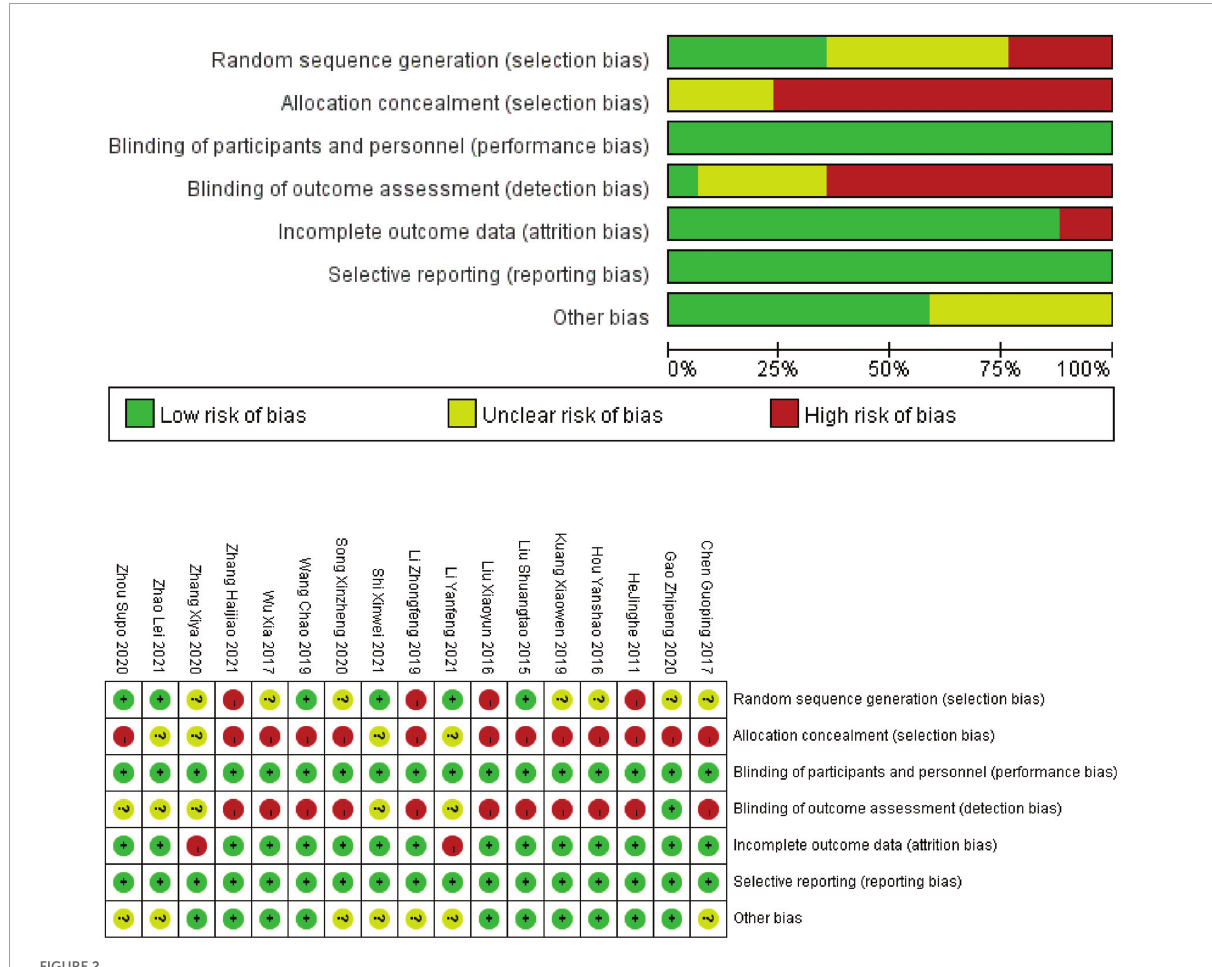
FIGURE2 Risk of bias graph and summary.